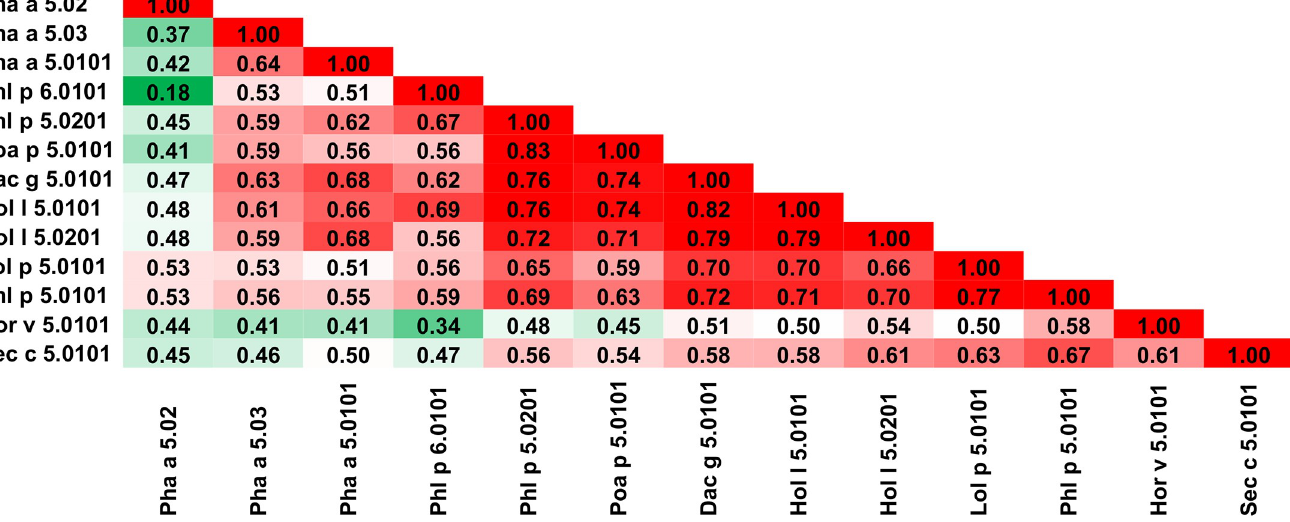
PLOS ONE | https://doi.org/10.1371/journal.pone.0208276 November29,